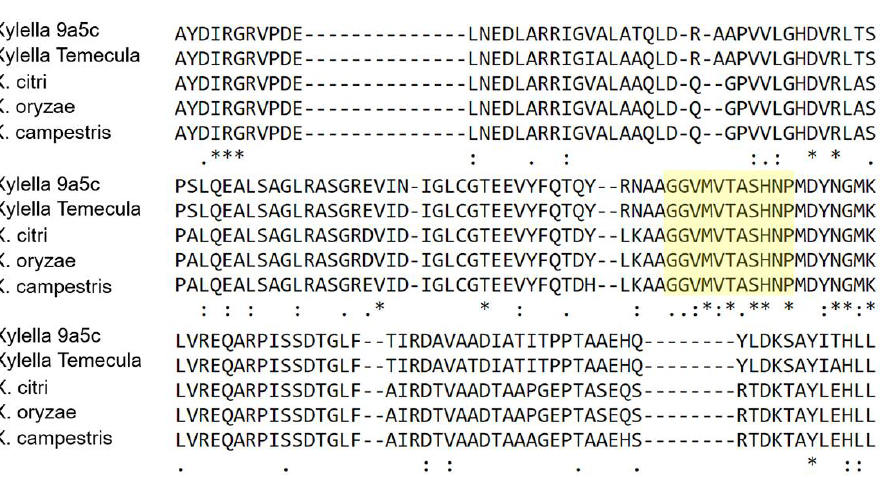
Figure 4. Sequence alignments of XanA homologs. The * indicates the presence of a conserved motif. The highlight region (GGVMVTASHP) characterizes the conserved domain Phosphoglucumutase and phosphomannomutase phosphoserine (PS00710). Abbreviations are as follows: Xylella 9a5c—Xylella fastidiosa 9a5c (XF_0260), Xylella Temecula—Xylella fastidiosa Temecula (PDO213), X. citri—X anthomonas citri subsp. citri (XAC3579), X. oryzae— Xanthomonas oryzae pv. oryza e (PXO_03174), XCC00626, X. campestris— Xanthomonas campestris pv. campestris str. ATCC 33913 (XCC0626). The